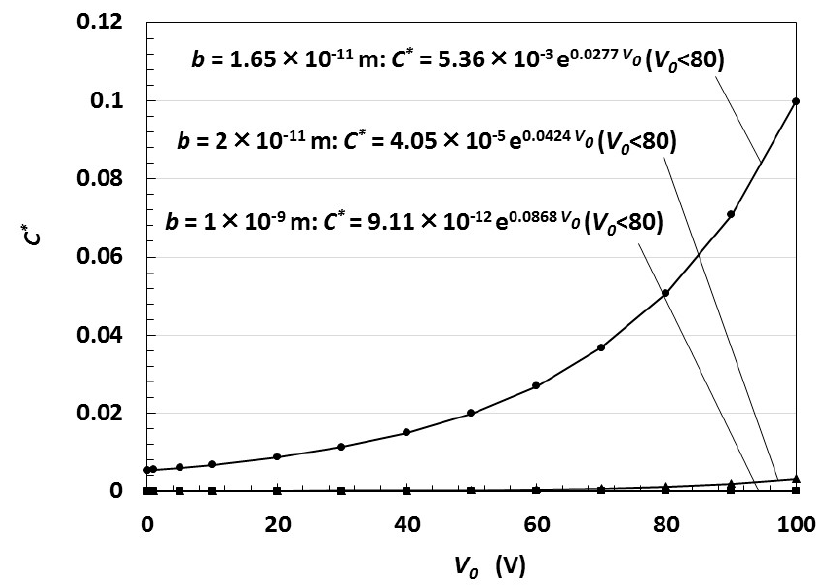
Figure 13. Theoretical results of the dimensionless capacitance C* to applied external voltage V o in relation to the thickness b of the nonconductive rubber between the metal or Fe 3 O 4 particles.